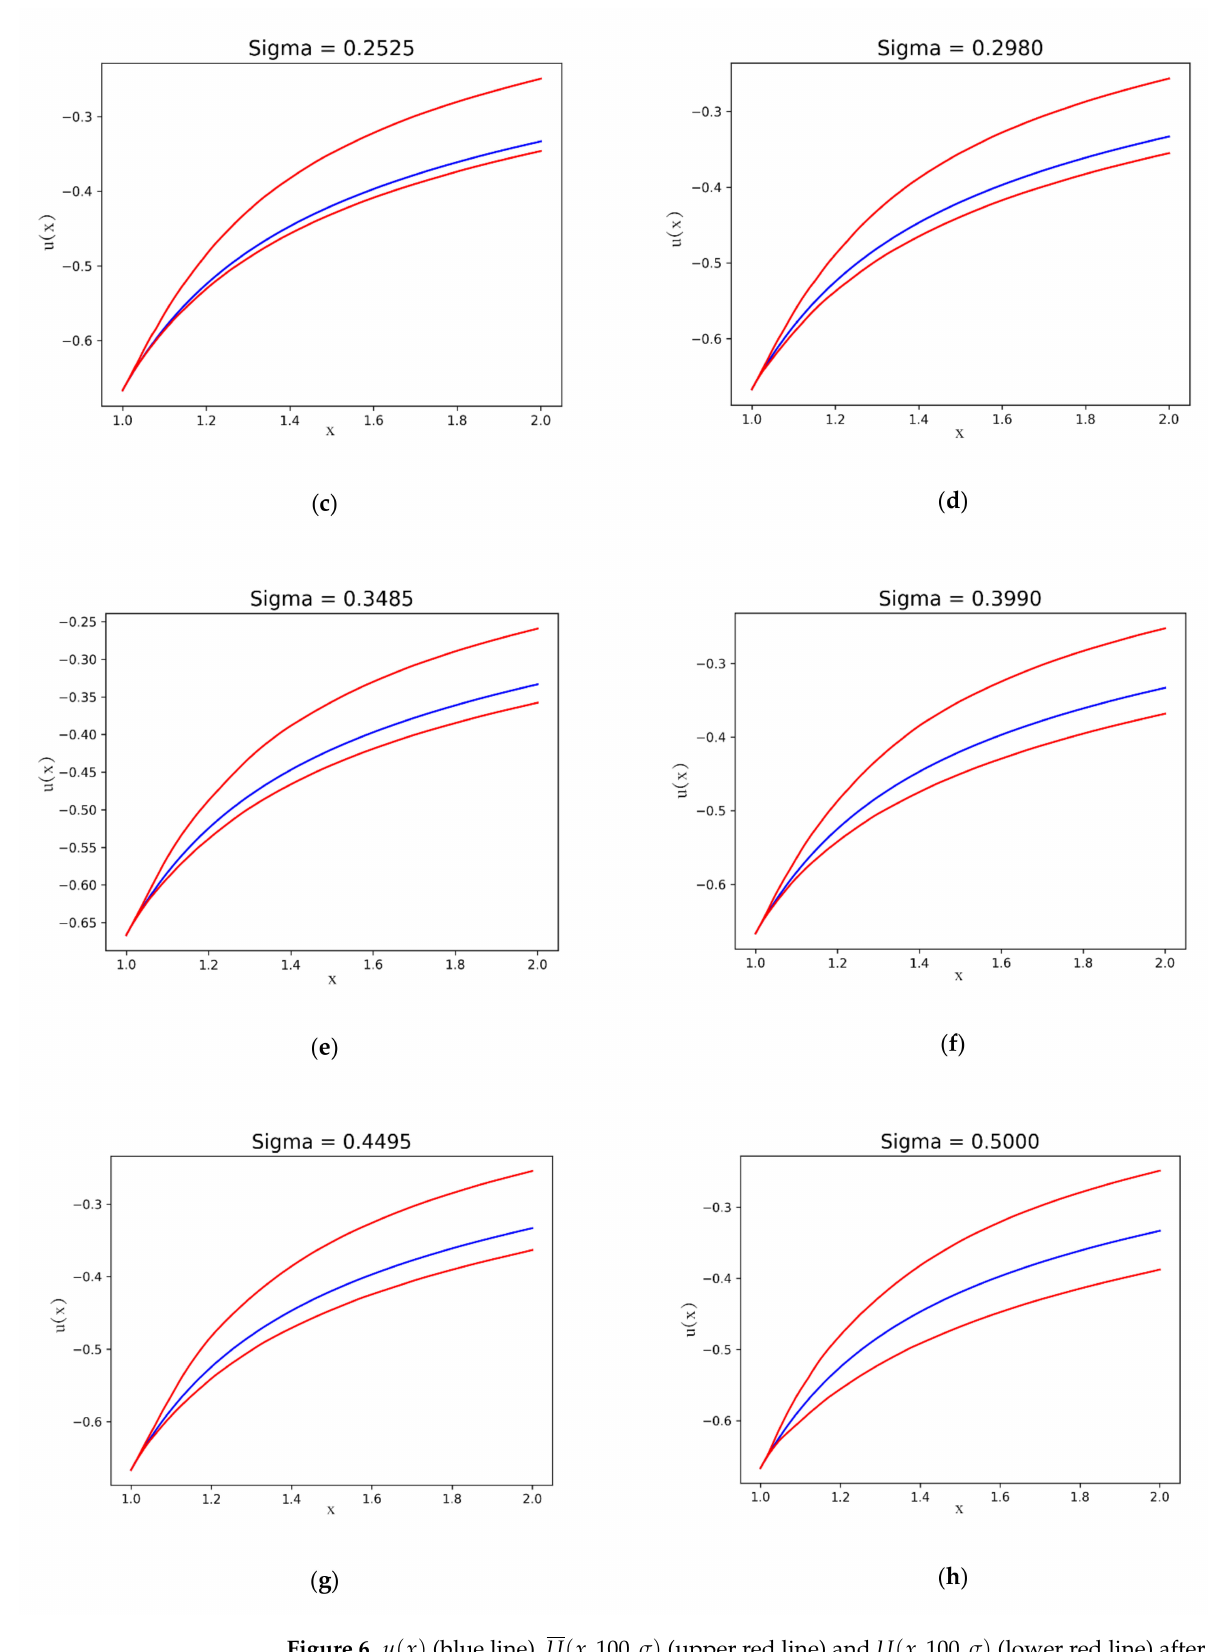
Figure 6. u ( x ) (blue line), U ( x ,100, σ ) (upper red line) and U ( x ,100, σ ) (lower red line) after 200 it- erations for different values of the standard deviation: ( a ) σ = 0; ( b ) σ = 0.1010; ( c ) σ = 0.2525; ( d ) σ = 0.2980; ( e ) σ = 0.3485; ( f ) σ = 0.3990; ( g ) σ = 0.4495; ( h ) σ =